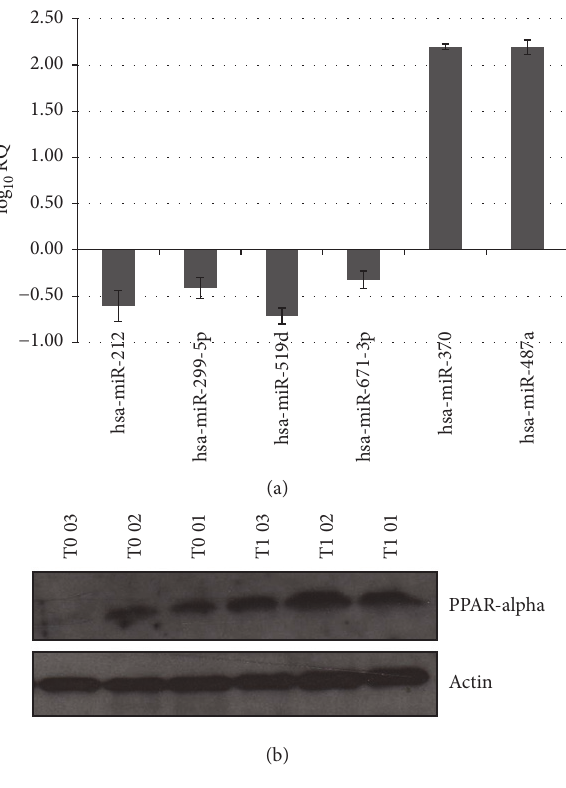
Figure 1: Six miRNAs whose expression changed in subcuta- neous adipose tissue (SAT) three years after LAGB (T1) and Western blot evaluation of protein PPAR 𝛼 , which is targeted by miR-519d. (a) Expression levels of 4 downexpressed (miR- 212, miR-299-5p, miR-519d, and miR-671-3p) and 2 upexpressed miRNAs (miR-370 and miR-487a) after LAGB (T1 versus T0). MiRNA expression levels are shown as mean log 10 RQ (the miRNA expression values were first normalized to RNU48, after which the relative quantification was calculated as RQ = 2 −ΔΔ Ct , where ΔΔ Ct = [Ct obese ( miRNA ) − Ct obese ( RNU 48) ] – [Ct calibrator ( miRNA ) –Ct calibrator ( RNU 48) ]. (b) Western blot evaluation of protein PPAR- 𝛼 from SAT of 3 obese patients before (T0) and three years (T1) after